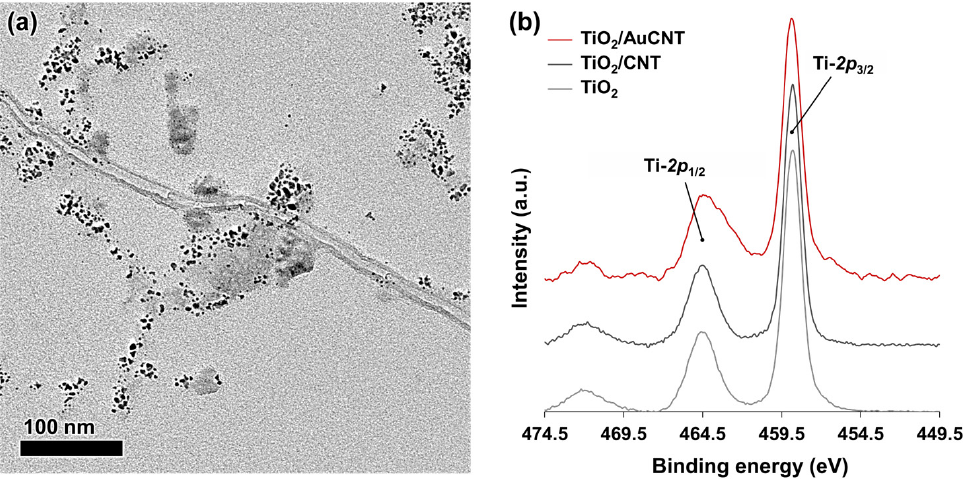
Figure 5. ( a ) TEM picture of TiO 2 /AuCNT; ( b ) XPS analyses of TiO 2 , TiO 2 /CNT, and TiO 2 /AuCNT.